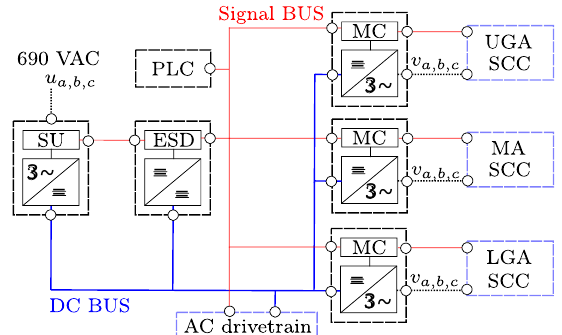
Figure 12: Proposed electric power distribution layout when using self-contained cylinders together with existing AC drivetrains (simplified